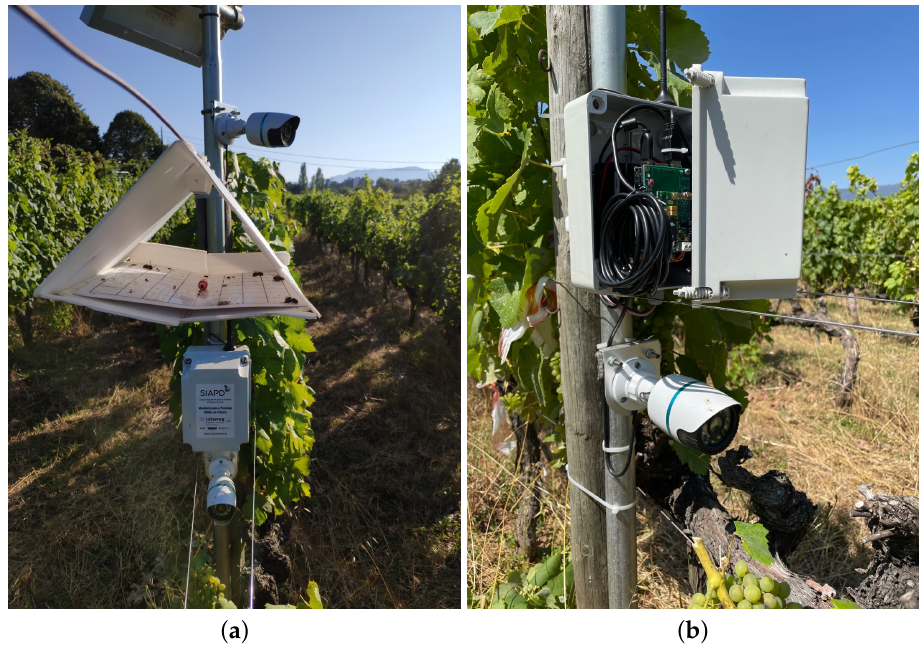
Figure 5. VineInspector installed in a UTAD’s vineyard, located on Campus: ( a ) the entire sys- tem, with the common delta sticky trap in foreground; ( b ) VineInspector’s detail, showing the upper